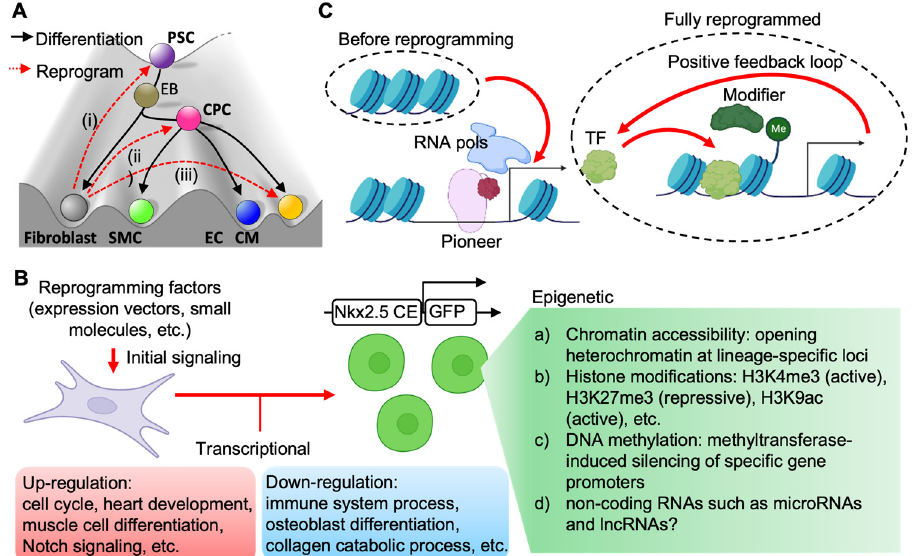
Figure 3. Molecular mechanisms of cardiac reprogramming. ( A ) Various reprogramming routes for converting fibroblasts into cardiovascular cells in Waddington’s epigenetic landscape model. ( B ) The transcriptional and epigenetic mechanisms involved in iCPC reprogramming. ( C ) Potential interactions between reprogramming pioneer factors and epigenetic modifiers, and establishment of an auto-regulatory loop of TFs. PSC: pluripotent stem cells; EB: embryonic body; CPC: cardiovascular progenitor cell; CM: cardiomyocytes; SMC: smooth muscle cell; EC: endothelial cell; TF: transcription factor; CE: cardiac enhancer.